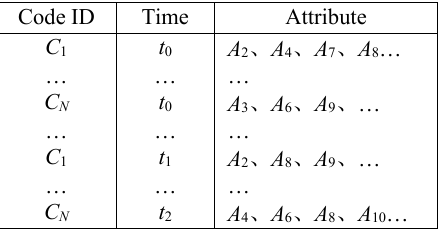
Table 2. Data modeling based on state